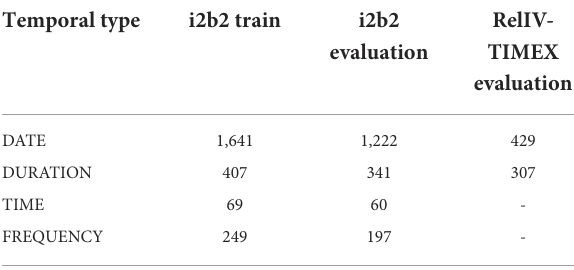
TABLE 1 Number of annotated temporal expressions for the four temporal types in the full i2b2 data set and the filtered RelIV-TIMEX data